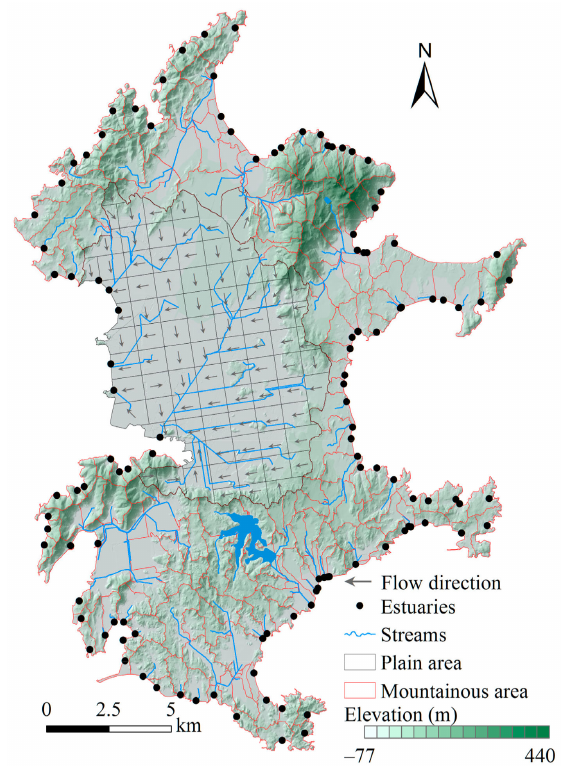
Figure 3. Discretization in the plain area with grids, the mountainous area with sub-basins, and the distribution of